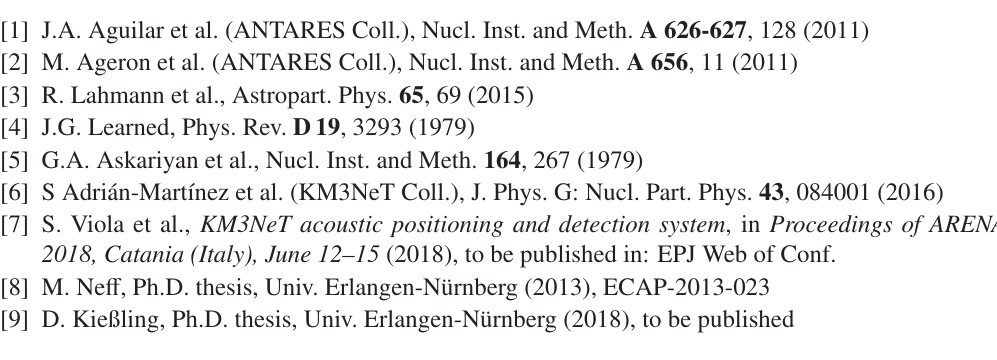
Figure 2. A comparison of the two di ff erent energy reconstruction methods. The dotted (dashed) histogram shows the true energy of the neutrino (shower). The shower energy reconstructed with the combined fit is displayed as a solid green (light) line, while the simple method from the feature extraction is shown in red (dark). The entries in this plot were generated for a KM3NeT Building Block. The bin size is larger than the typical error on the energy obtained from the combined fit. See [9] for further